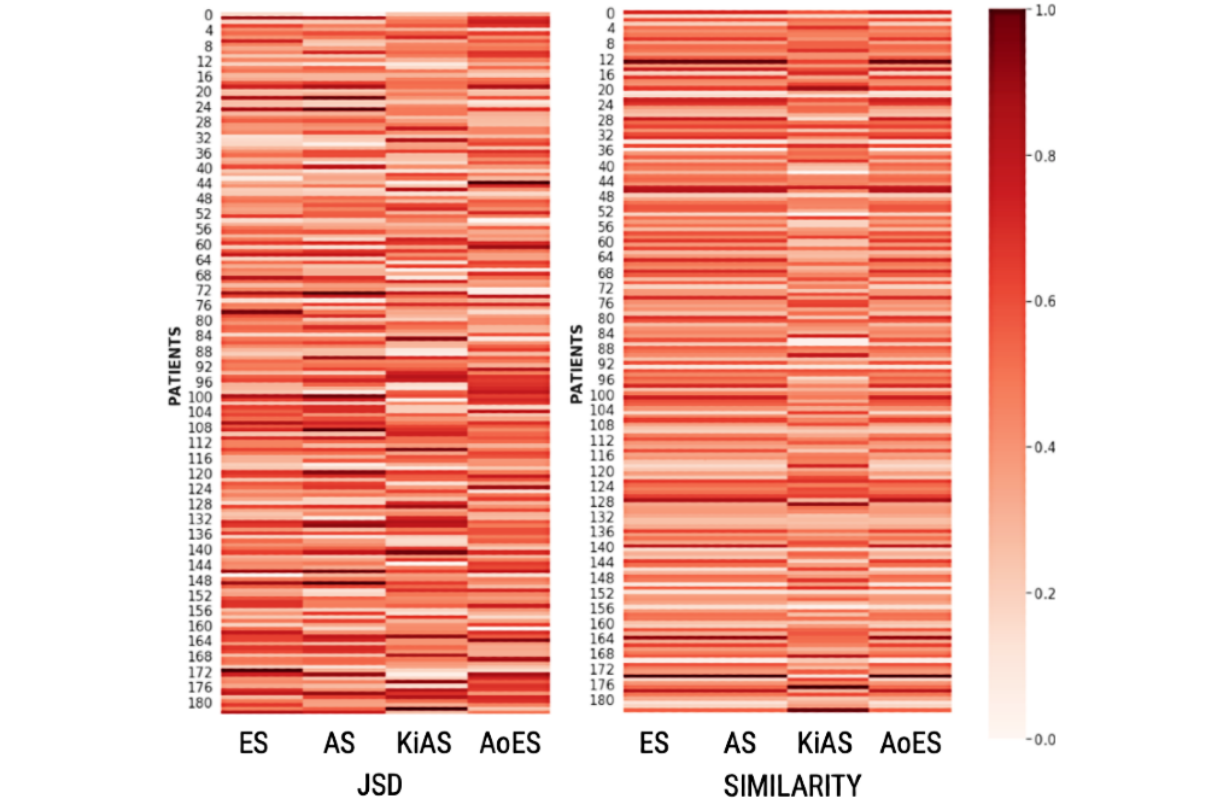
Figure 5. The heatmap shows the evaluation of generated summaries using information entropy and contextual similarity metrics. The figure shows the performance of KiAS against three baselines on retaining the content and context in summaries. AoES: abstraction over extractive summarization;